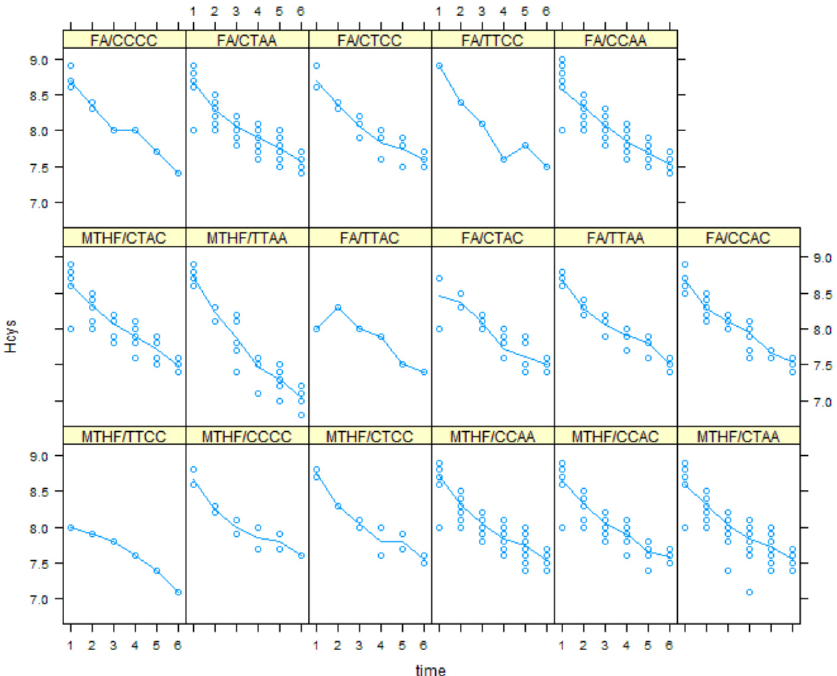
Fig 5. Serum tHcys concentration in folic acid and MTHFR groups in different MTHFR polymorphisms over